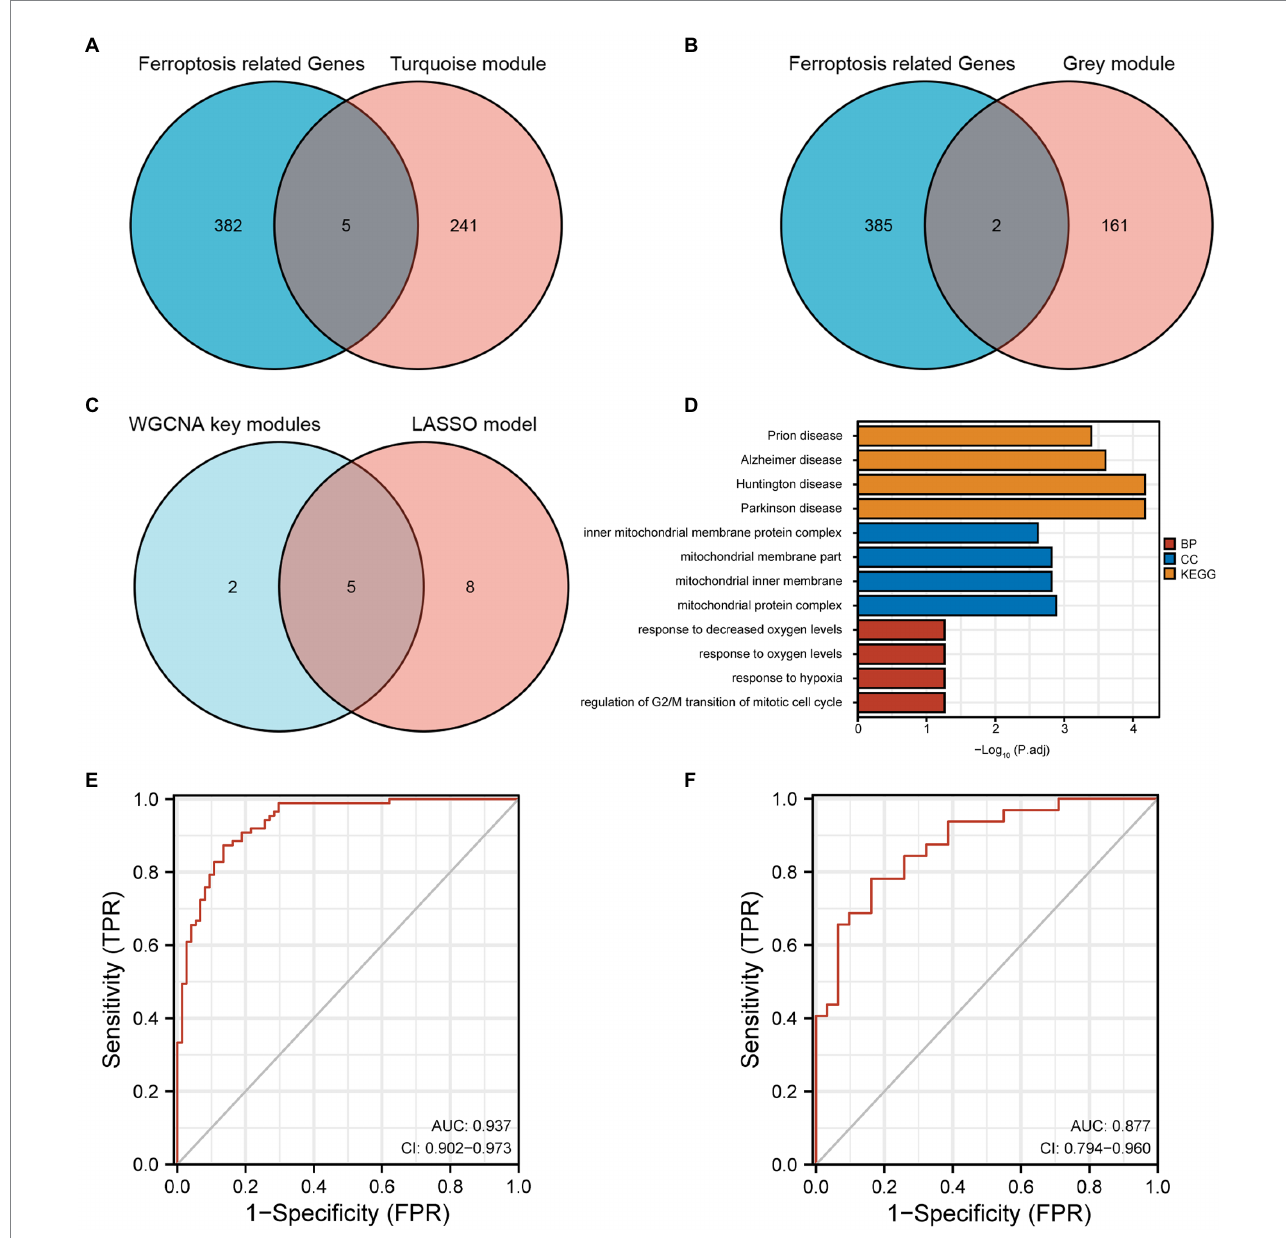
FIGURE 4 (A) Five FRGs obtained from the turquoise module. (B) Two FRGs obtained from the grey module. (C) Five FRGs from the intersection of the LASSO model and WGCNA key modules. (D) Main pathways of the genes from WGCNA key modules using functional enrichment analysis. (E) The ROC curve and the AUC of the five FRGs in GSE5281 (experimental set). (F) The ROC curve and the AUC of the five FRGs in GSE29378 (validation set). FRGs, ferroptosis-related genes; WGCNA, weighted gene co-expression network analysis; ROC, receiver operating characteristics; AUC, area under the curve; LASSO, least absolute shrinkage and selection